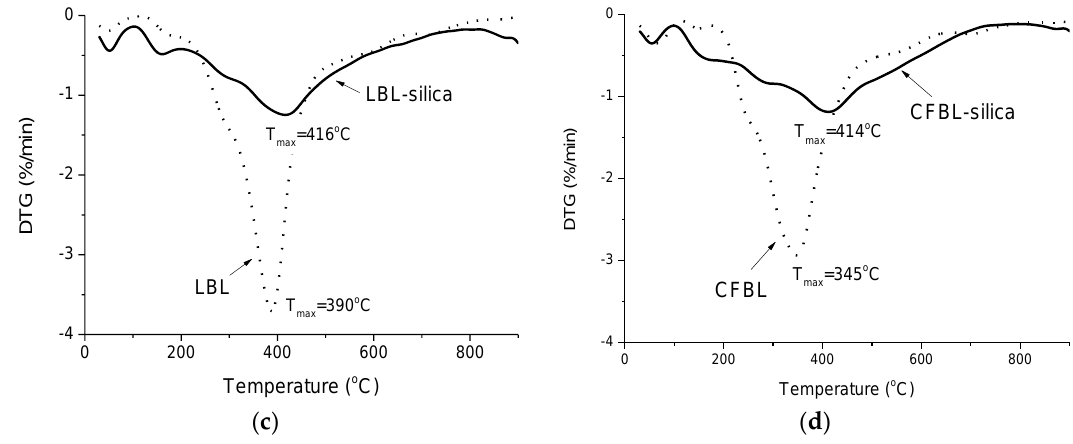
Figure 9. TG ( a , b ) and DTG ( c , d ) curves of thermal decomposition in a N 2 atmosphere for the original LBL and CFBL lignins.